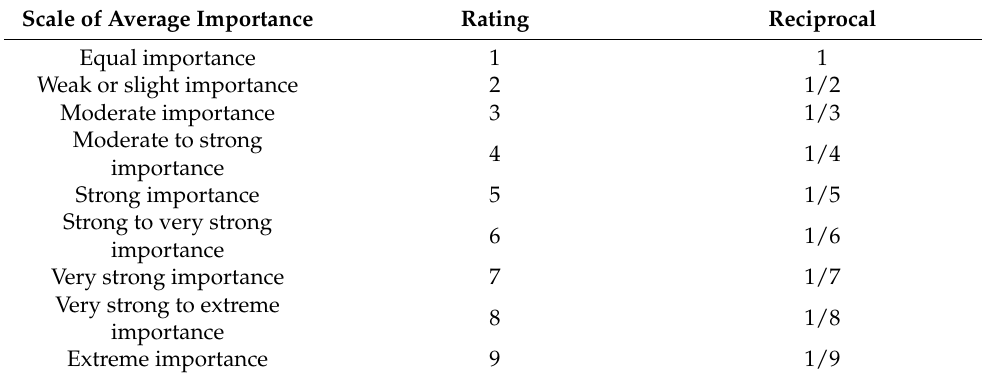
Table 5. Scale of average